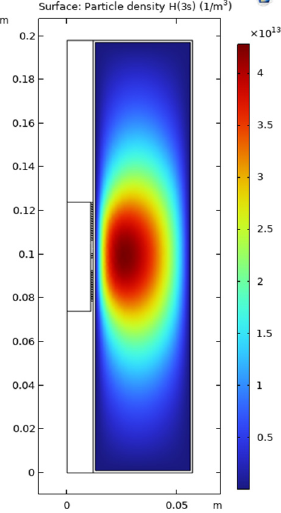
Figure 8. Comparison between normalized measured intensity and simulated reaction rate as a function of Ar/H 2 mixing ratio.